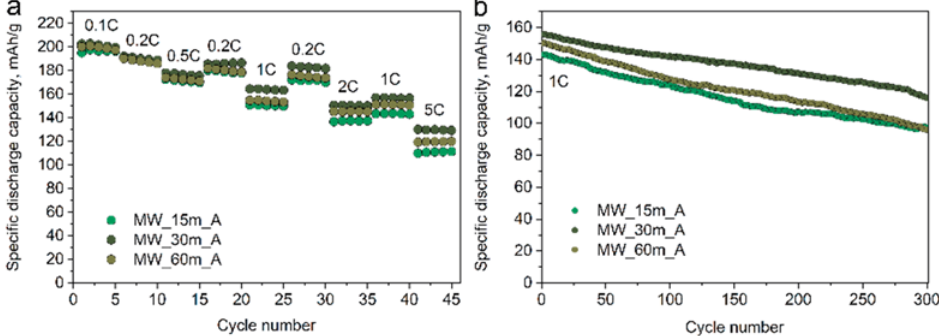
Table 3. Discharge capacity and capacity retention for the MW and CP NMC811 samples.